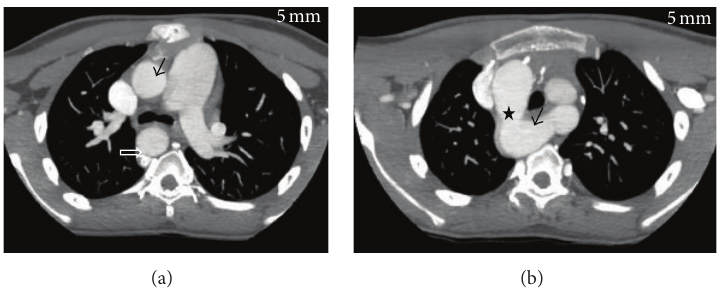
Figure 1: Axial MIP images at the level of ascending aorta and aortic arch showing right sided aortic arch and aberrant origin of left subclavian artery. (a) Ascending aorta (black arrow), descending aorta (open arrow), (b) aortic arch (star) and aberrant origin of left subclavian artery with diverticulum of Kommerell (black arrow).